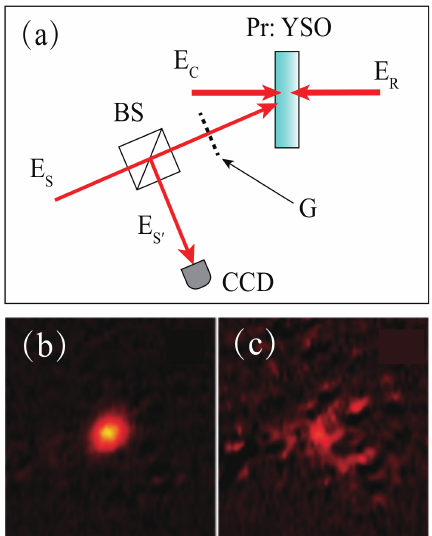
Figure 5. ( a ) Schematic diagram of the experimental configuration used to generate the nondegenerate phase-conjugate wave based on the light pulse storage and retrieval technique in Pr:YSO crystal. BS: beam splitter, CCD: charge coupled device, G: a phase-distorted glass slit. The signal pulse passed through the phase-distorted glass slit before interacting with the coupling beam in Pr:YSO crystal. ( b ) The perfect beam spot was recovered after the phase-distorted nondegenerate phase-conjugate wave repassed through the phase-distorted glass slit reversely. ( c ) The output was a messy speckled beam spot when the readout beam angularly deviated from the phase-matching condition by 1.7 mrad. Figure adapted from reference